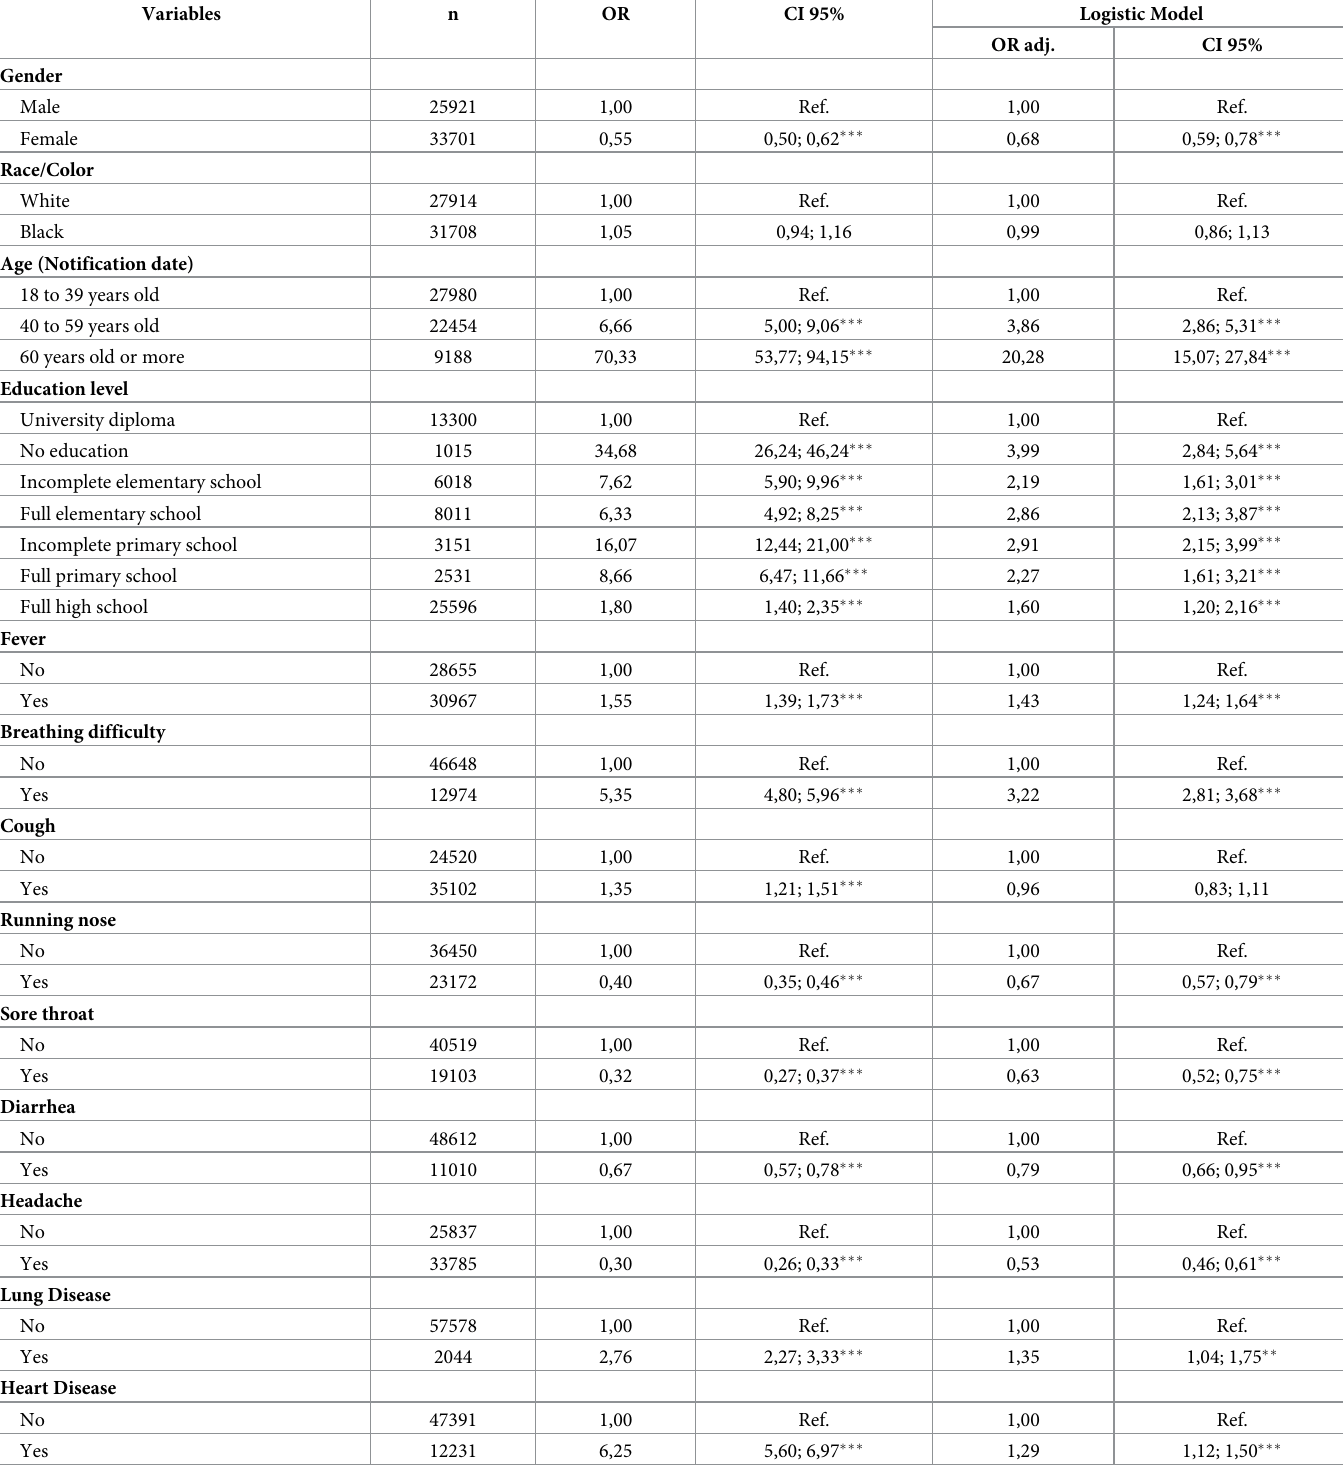
Table 6. Logistic regression model for the association of sociodemographic factors and symptoms with death by COVID-19 in patients with obesity, Espı´rito Santo, Brazil,